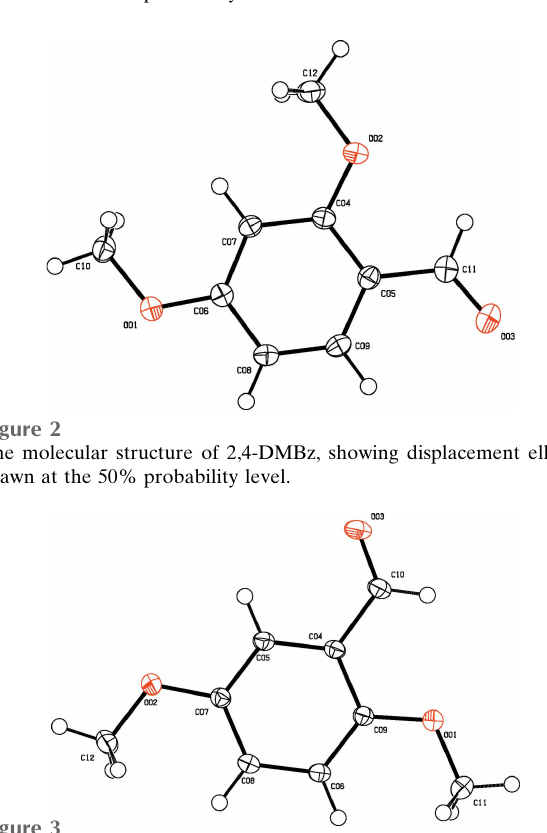
Figure 4 The molecular structure of 3,5-DMBz, showing displacement ellipsoids drawn at the 50% probability